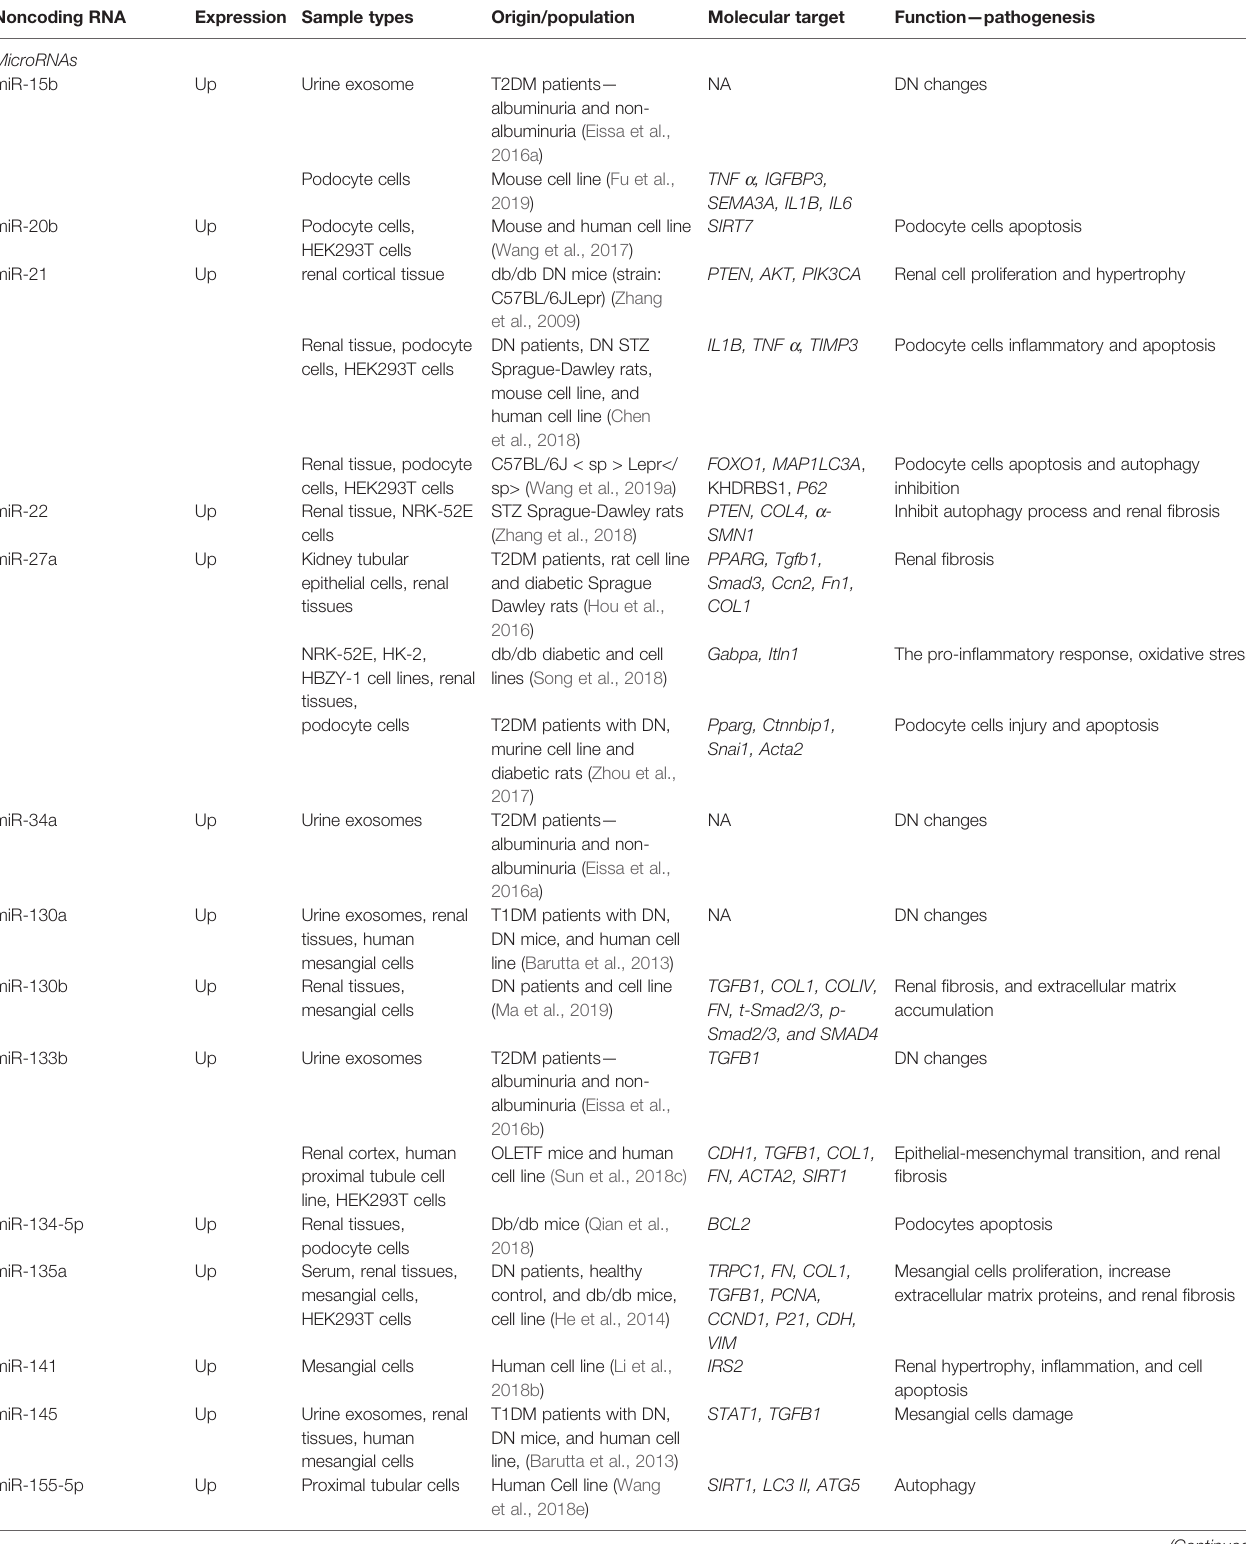
TABLE 1 | List of the reported noncoding RNAs in Diabetic Nephropathy. Noncoding